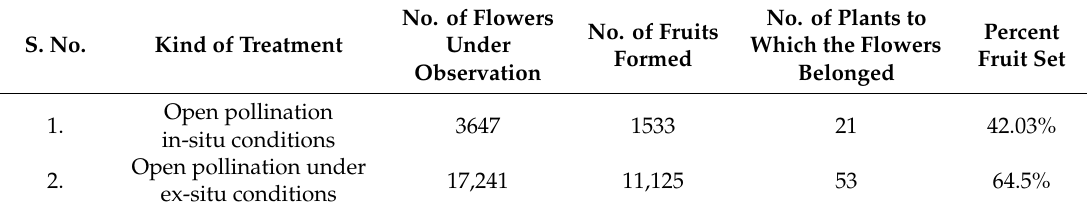
Table 2. Reproductive output under in-situ and ex-situ conditions.